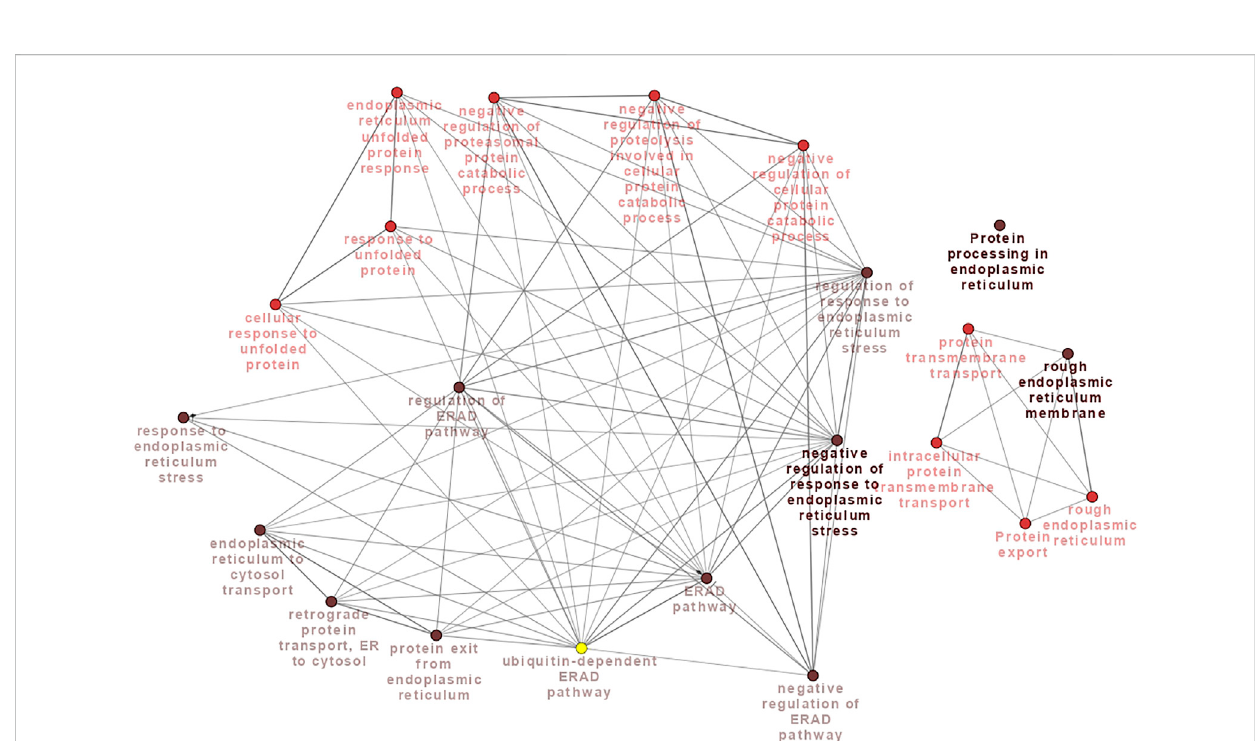
FIGURE 6 The association of the identi fi ed signi fi cant terms which enriched by the meta-genes.